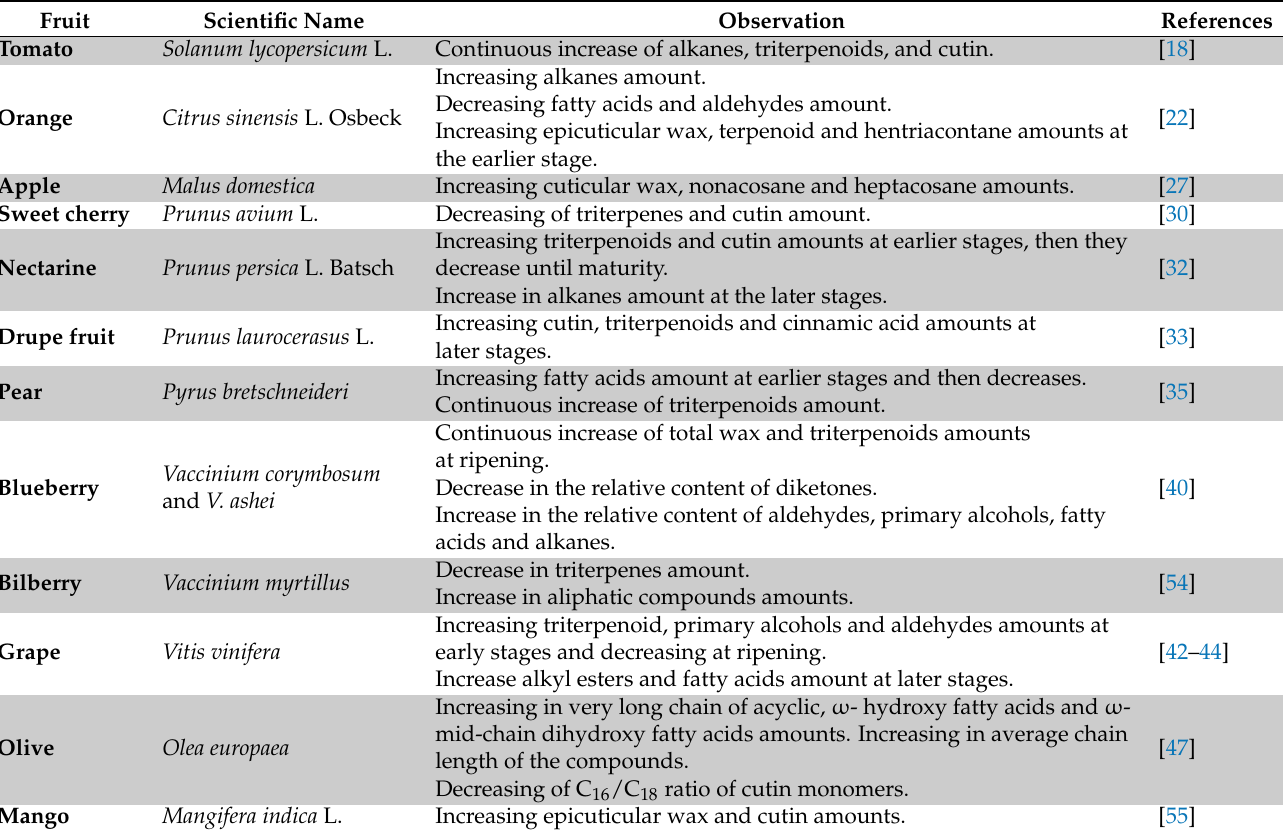
Table 2. Cuticle composition changes recorded during fleshy fruits